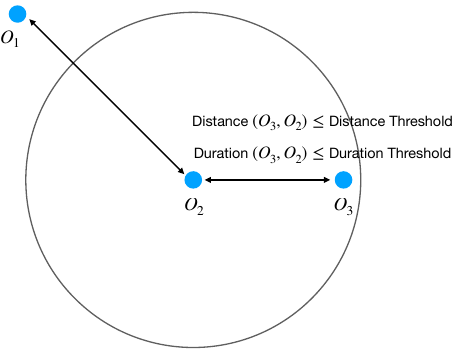
Figure 7. An example of practical observations O 1 , O 2 , and O 3 in the study where O 1 falls outside the distance and duration threshold of O 2 and O 2 falls inside the thresholds of O 3